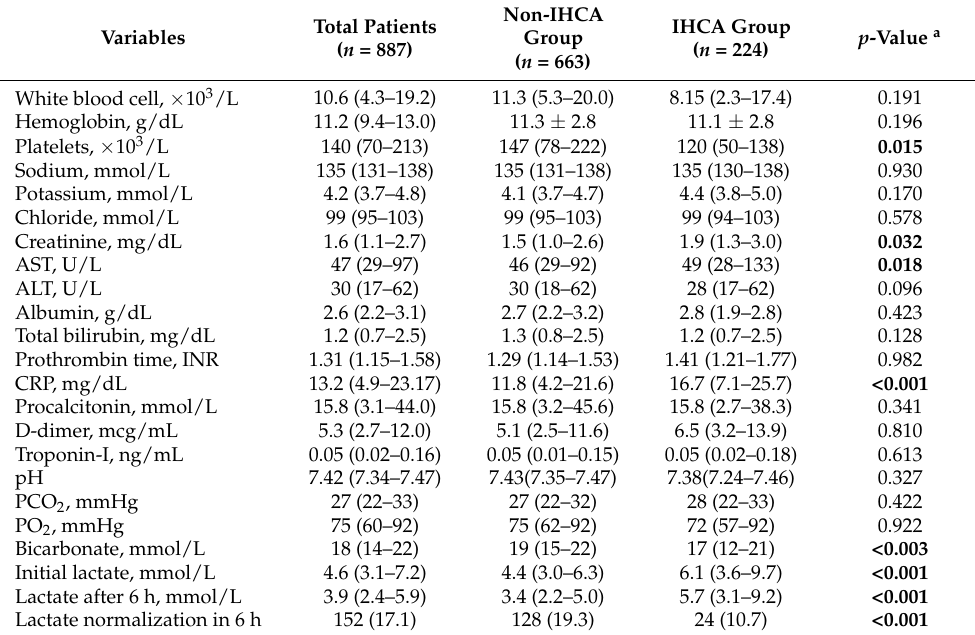
Table 2. Comparison of laboratory findings between the IHCA and non-IHCA groups.